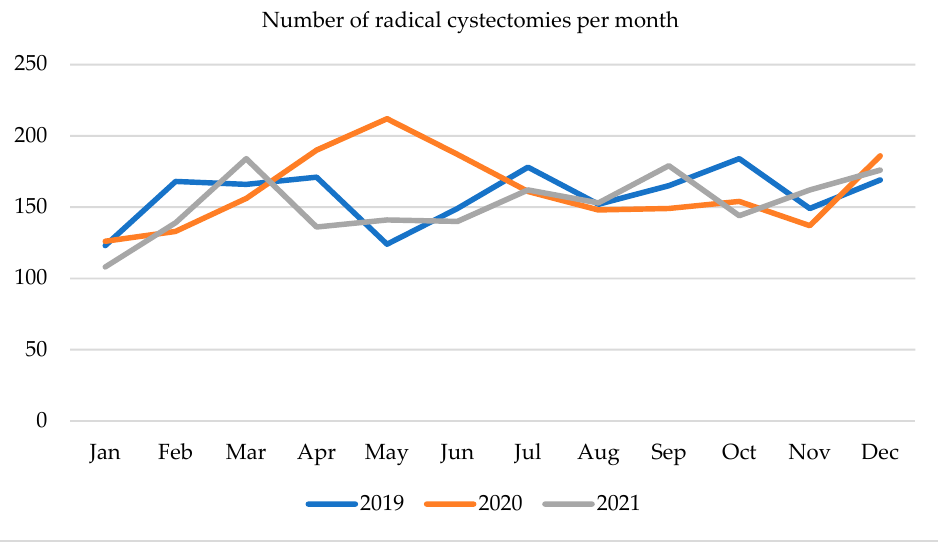
Figure 2. Number of radical cystectomies per month in 2019 – 2021.